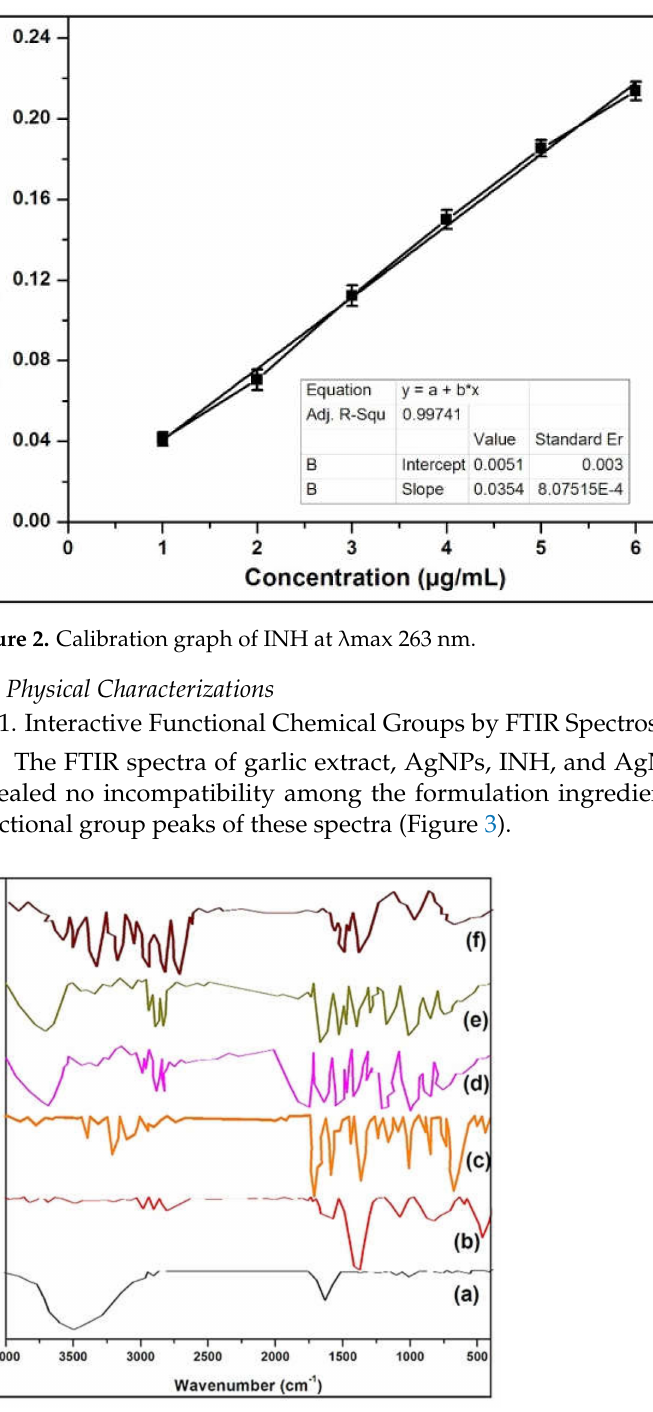
Figure 3. The FTIR spectrum of ( a ) Garlic extract, ( b ) AgNPs, ( c ) INH, ( d ) F7, ( e ) F10, and ( f ) F13. The FTIR of aqueous garlic extract (Figure 3a) exhibited a peak at 1644.02 cm − 1 , which is assigned to carbonyl or carboxylic acid (C=O) stretching of peptide (amide) linkages, while the peaks at 1132.97 cm − 1 and 1032.69 cm − 1 were due to SO 2 absorption of sulphones and primary amines, respectively. The peak at 1407.78 cm − 1 reflects the amide II band. These data are in accordance with earlier reports